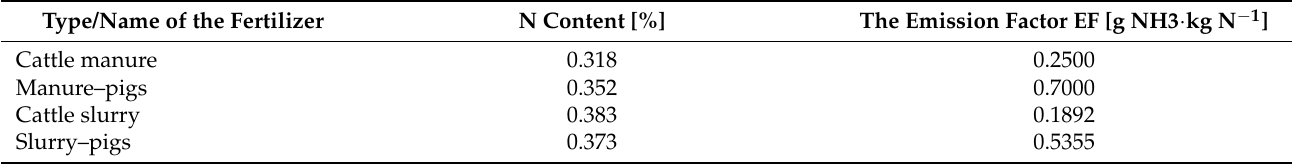
Table 4. N content in respective kinds of natural fertilisers 1